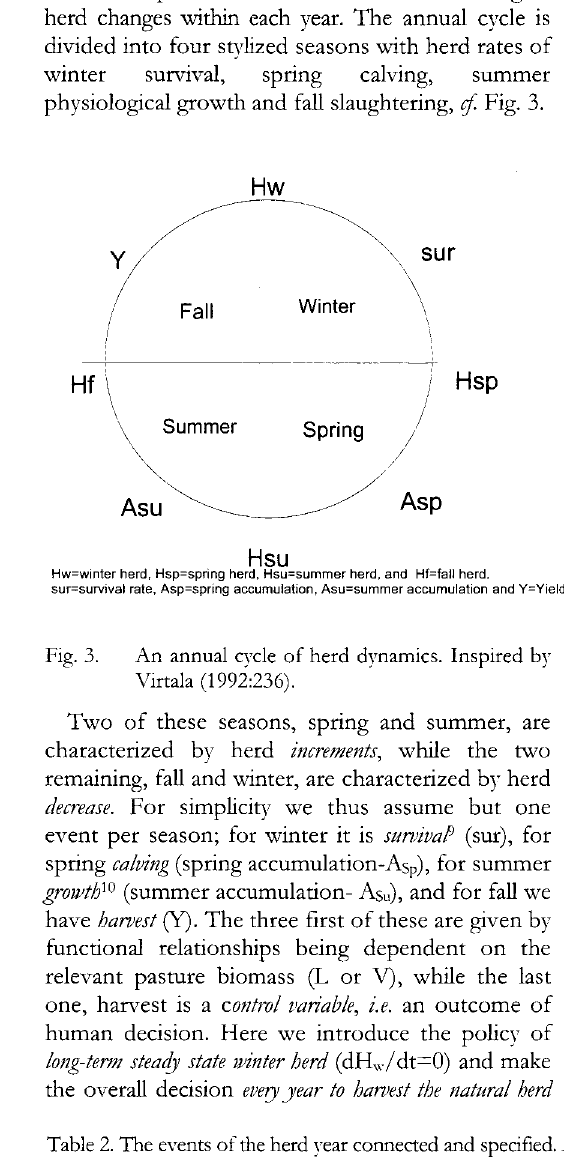
Table 2. The events of the herd year connected and specified. All parameters are nonnegative <1.